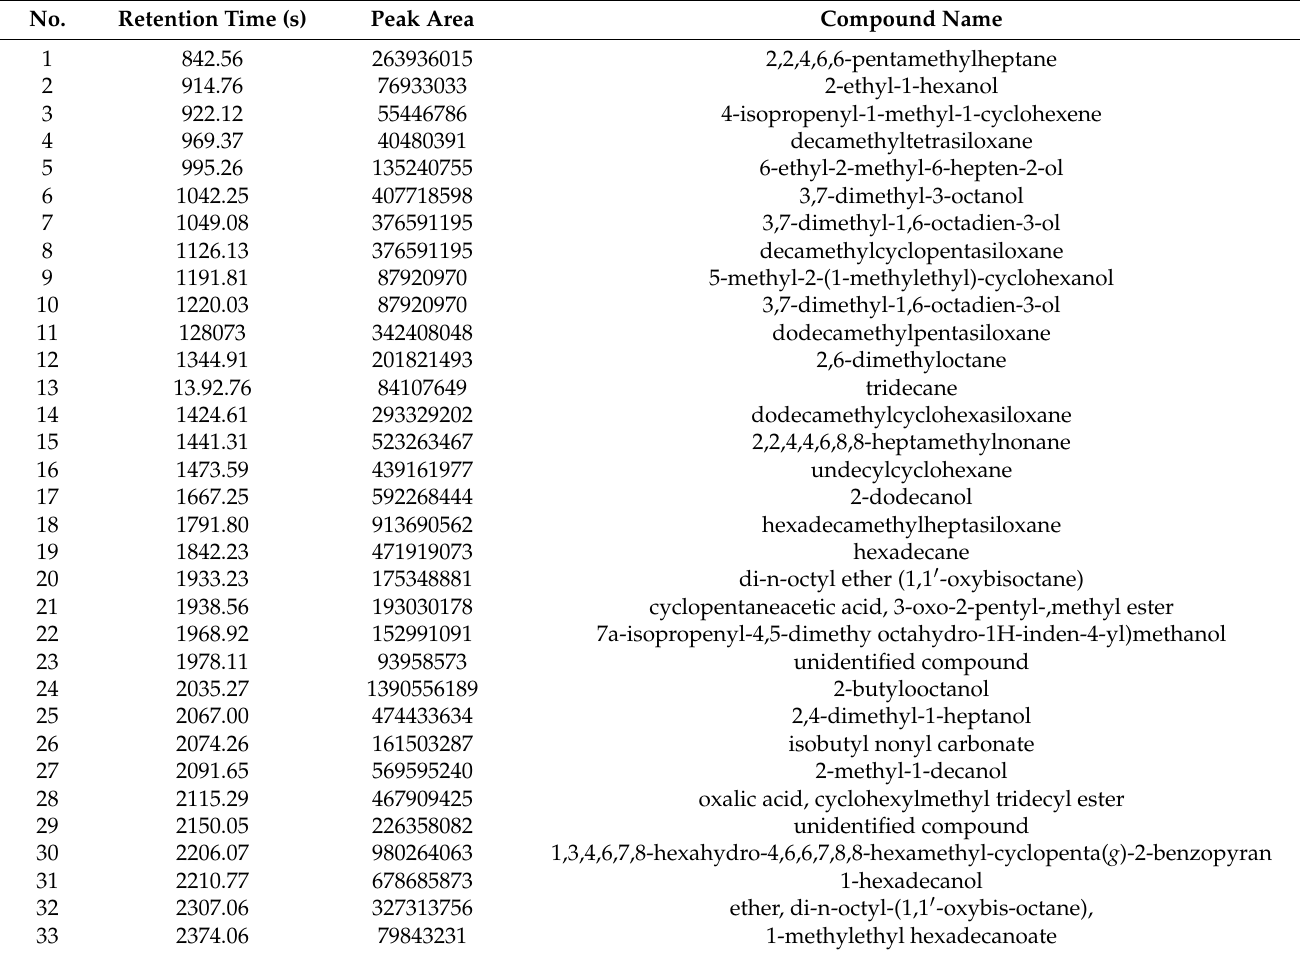
Table 2. Raw wastewater head space-solid phase micro extraction–gas chromatography–mass spectrometry (HS-SPME–GC– MS) analysis